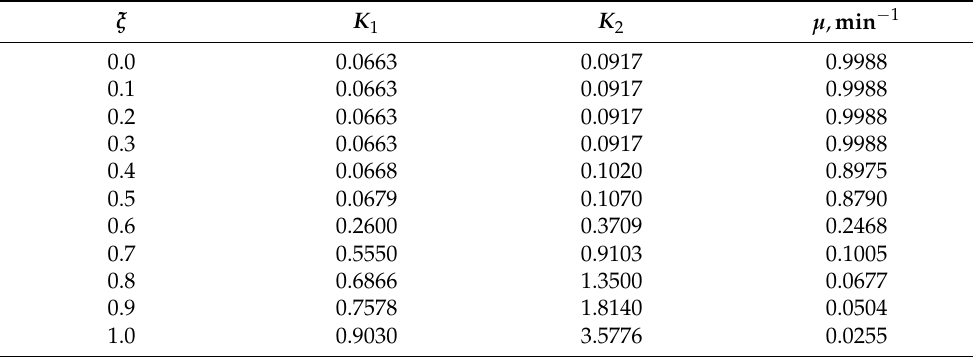
Table 3. Optimization results by the method using a backtracking search algorithm.